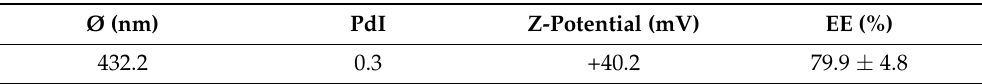
Table 5. Hydrodynamic diameter, PdI, Z-potential and entrapment efficiency (EE) of CS/siRNA tat/rev complexes prepared with CS 50 KDa and N/P = 10.